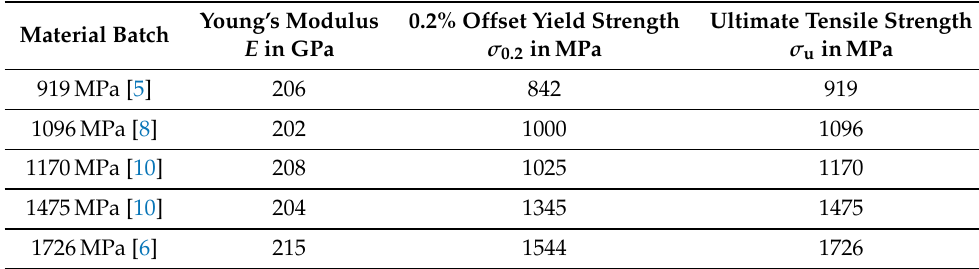
Table 2. Tensile test results.